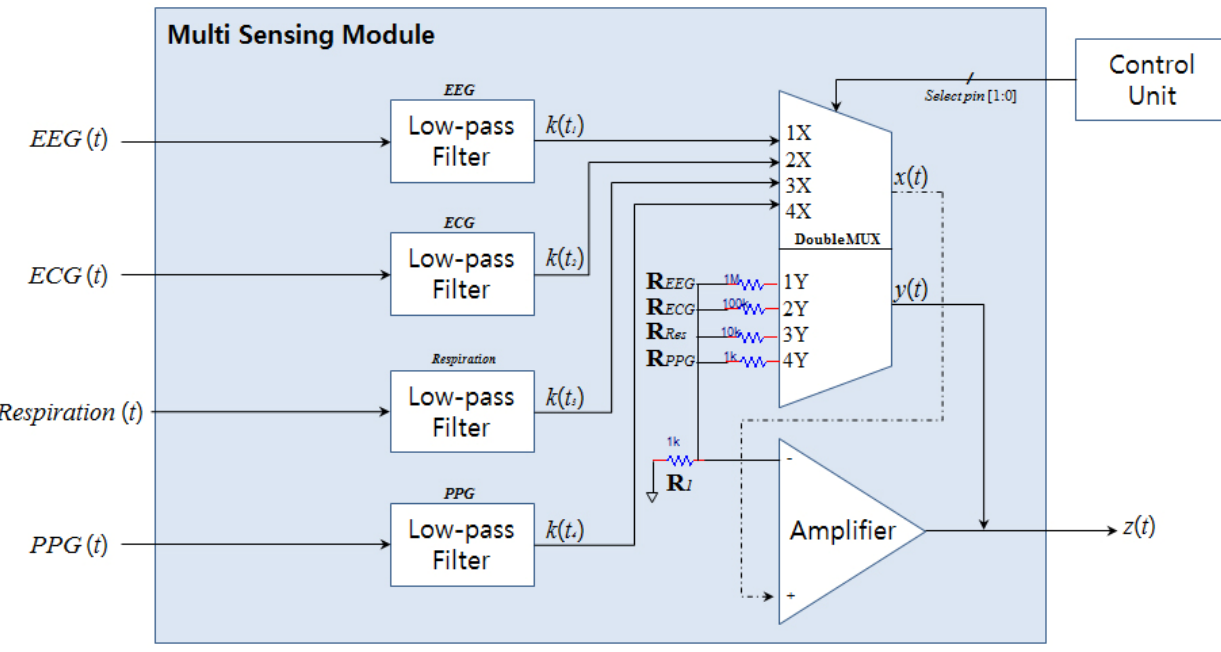
Figure 3. Structure of multi sensing